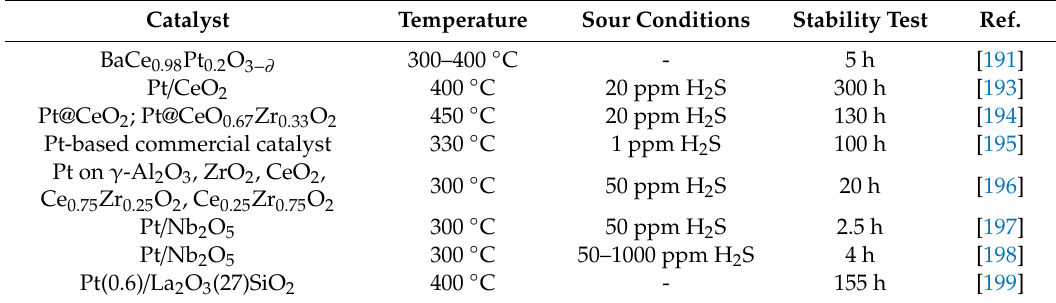
Table 13. Summary of the evaluated deactivation conditions reported in Section 5: Deactivation Studies. Catalyst Temperature Sour Conditions Stability Test Ref.